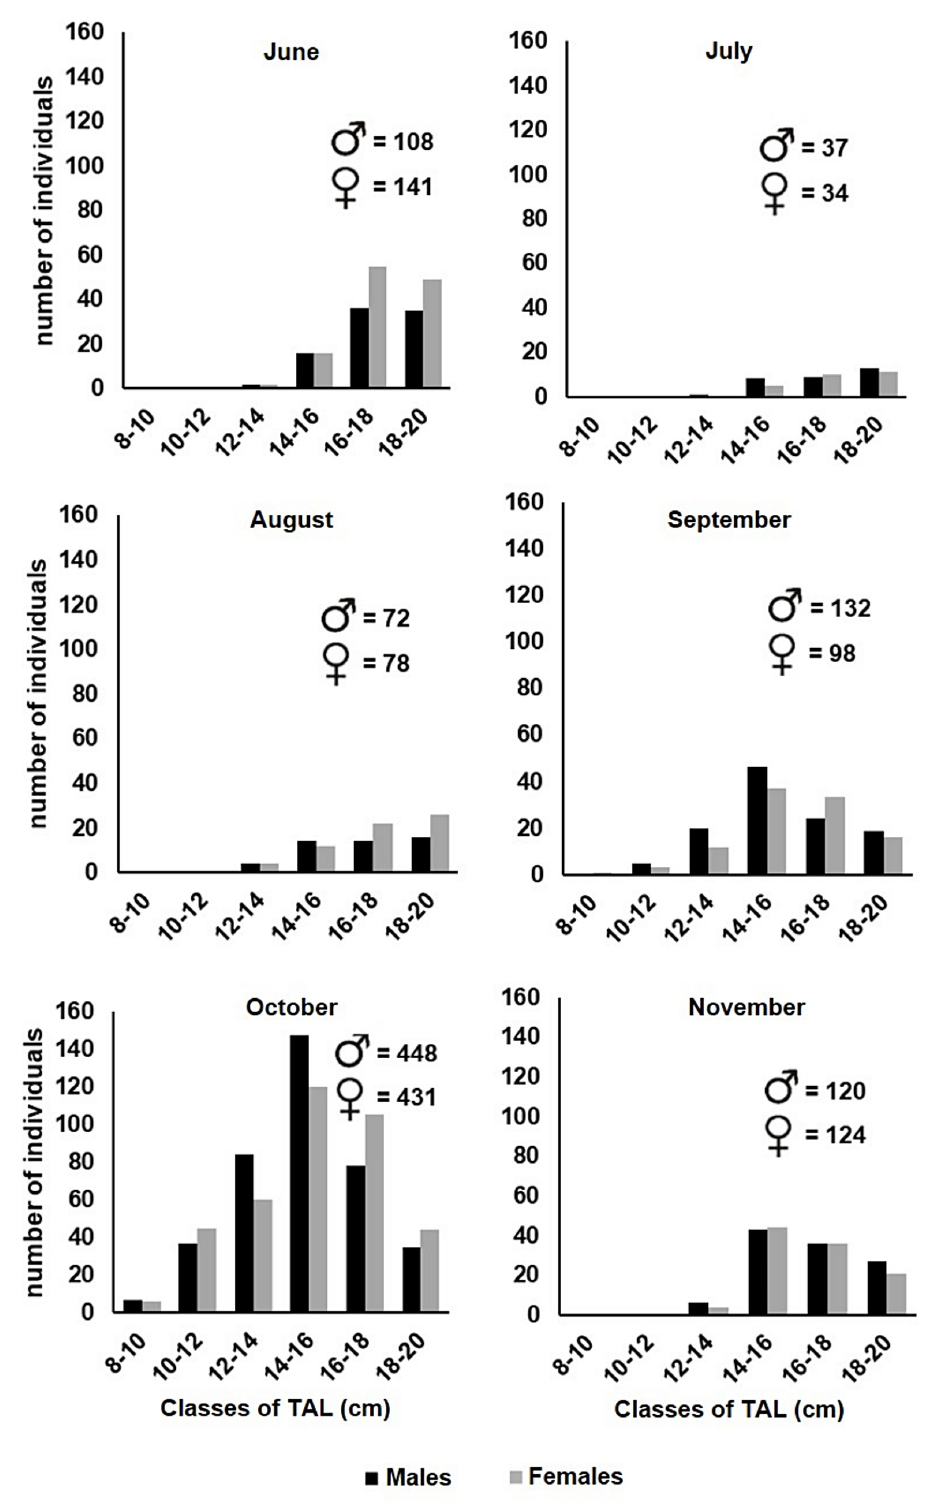
Figure 5. Frequency distribution of tail length classes (TAL), per sampling month and intersexual comparison for the species Panulirus laevicauda